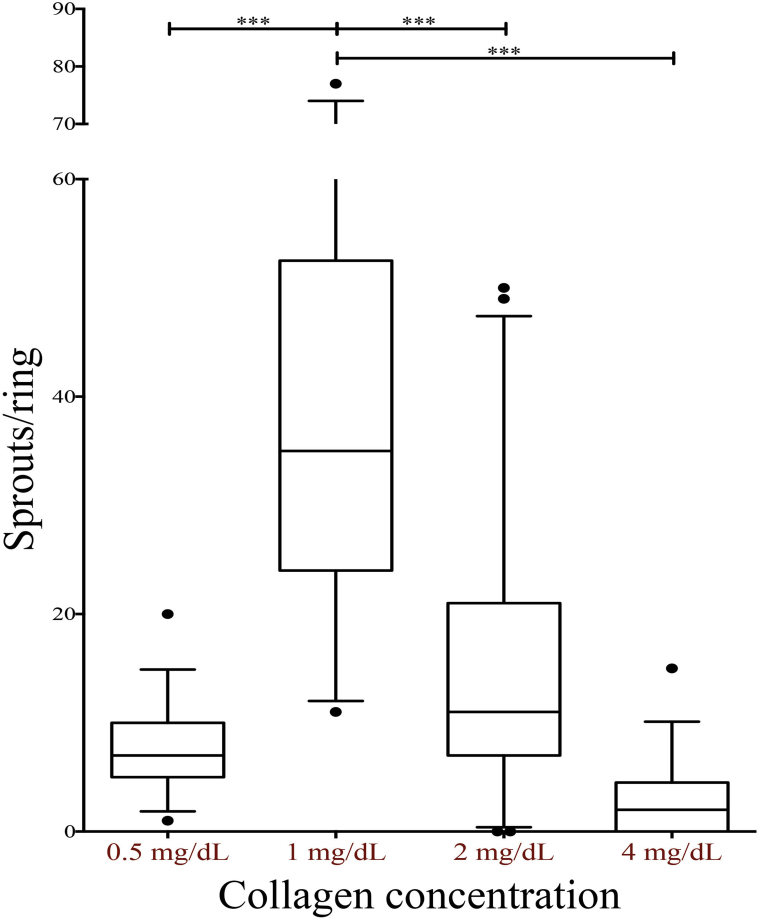
Supplementary Fig. 2Effect of collagen concentration on angiogenesis in mice aortic rings. The summary data of the aortic ring angiogenesis assays are shown in the form of box (median and interquartile ranges) and whisker (95% range) graphs. Each data-point represents an aortic ring with experiments performed in multiple replicates [6], [7], [8], [9], [10], [11], [12] with at least three biological replicates using different Collagen concentrations to embed the aortic rings. Statistical analyses were performed by Kruskal-Wallis test with Dunn's post-hoc multiple comparison. *p < 0.05, **P < 0.01, ***p < 0.001.